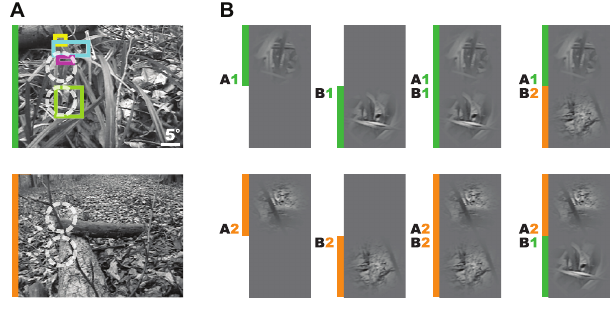
Figure 1. Acquisition and presentation of natural movies. ( A ) Movie frames extracted from two different movies (marked orange/green ) are shown. Prior to optical recordings retinotopy across the imaged cortical region was evaluated by hand mapping of receptive field locations (colored rectangles) at various penetration sites. This ensured that the distance between the mid- point of apertures was bigger than the range of classical receptive fields. ( B ) For each experiment, two base natural movies (marked orange/green ) were used to create different stimulation conditions. Movies were presented through either one or two Gaussian masks (3˚ or 4˚ FWHM, see Materials and Methods) centered at positions A (top position) or B (bottom position), illustrated by white circles. According to the position label ( A or B ) and the index of the natural movies Movie 1 or Movie 2, the following conditions were displayed: single ( A 1, B 1, A 2, B 2), in which only one local patch was shown; coherent ( A 1 B 1, A 2 B 2), in which two local patches belonged to the same full-field movie; and incoherent ( A 1 B 2 and A 2 B 1), with local patches derived from different movies (see rightmost